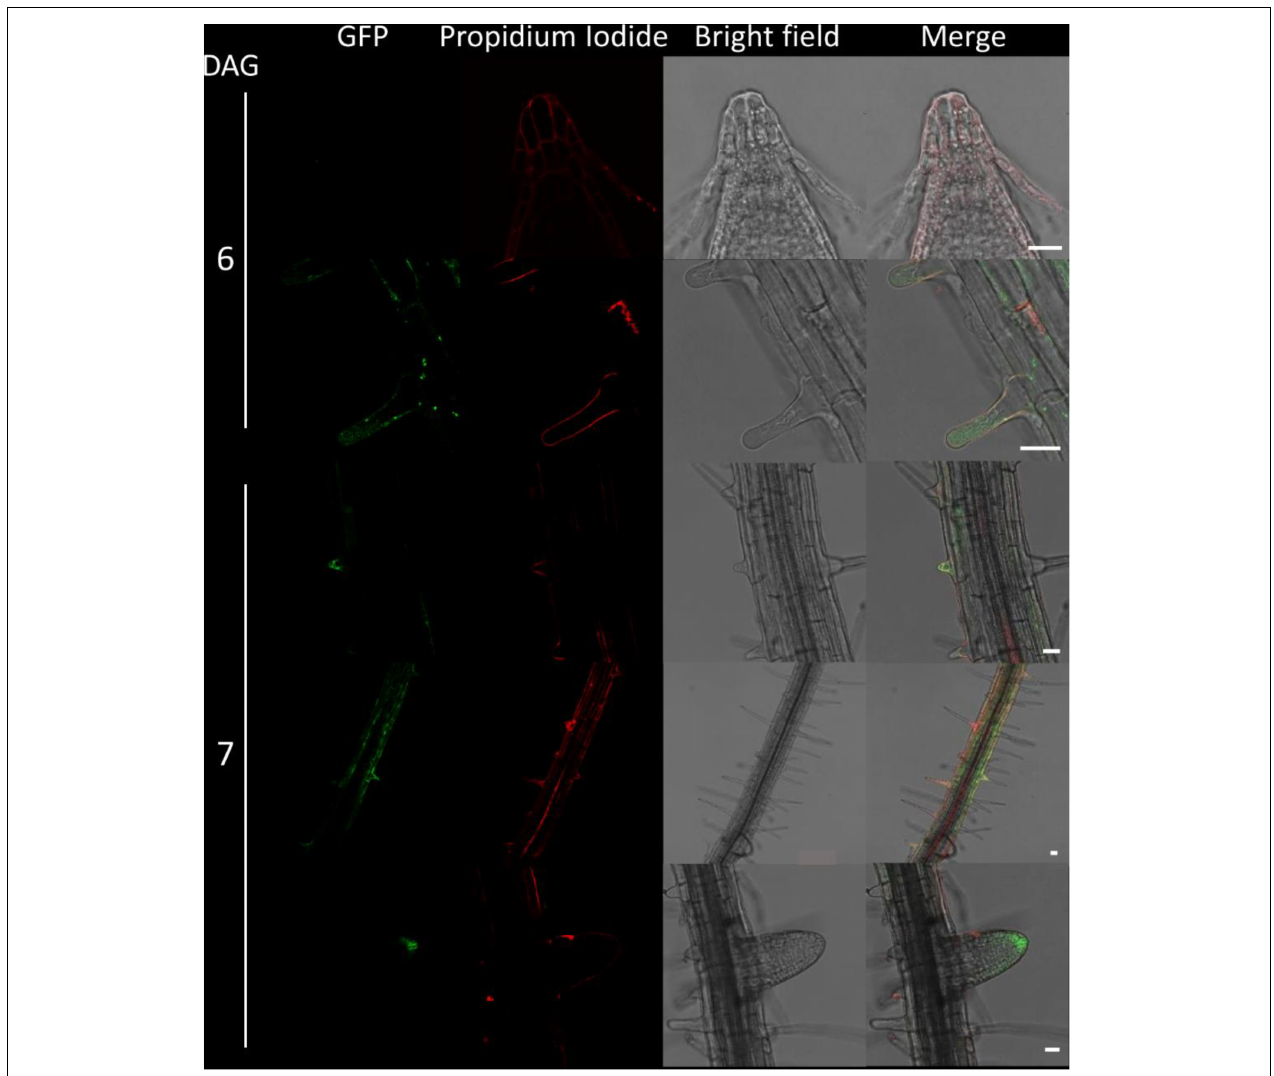
FIGURE 6 | Fluorescence imaging of CTPS2::GFP lines in seedling roots. Growth and microscopy conditions as in Figure 5 . Scale bar = 25 µ m. DAG, days after